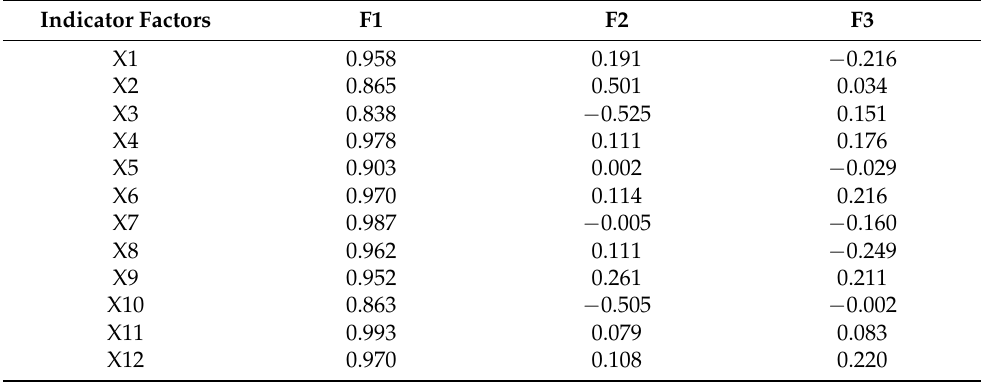
Table 8. Main component rotation load